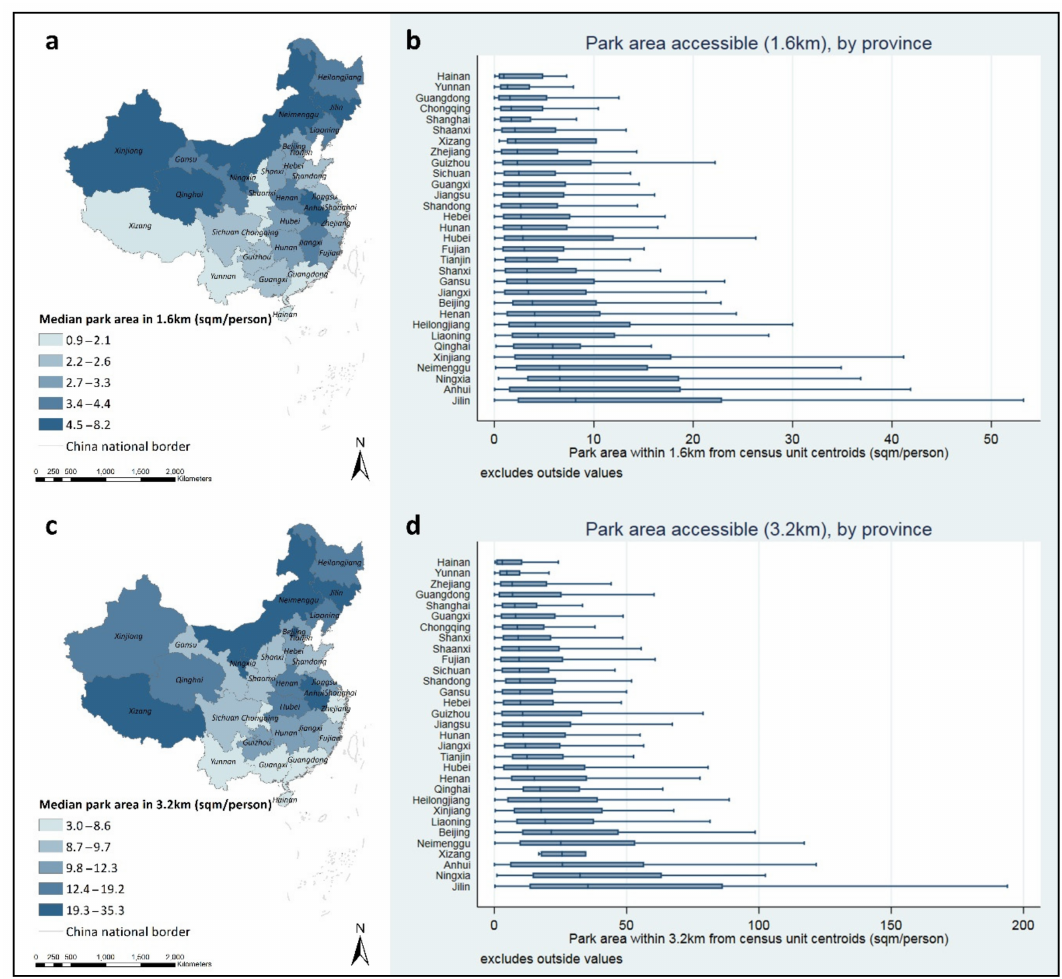
Figure 3. Provincial disparities of park area ( a uses 1.6 km and c uses 3.2 km) and box plots of park area by province ( b uses 1.6 km and d uses 3.2